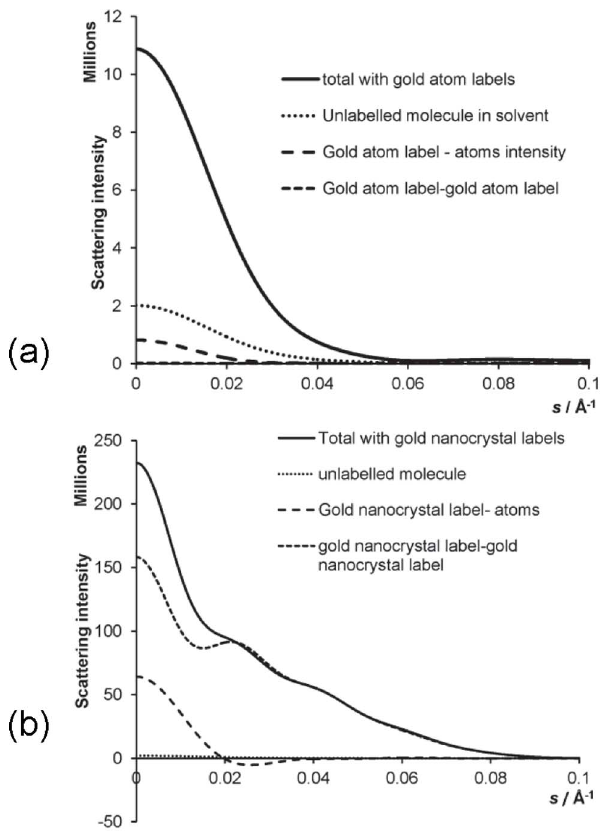
Figure 2. The intensity as a function of the momentum transfer vector magnitude, s , for a 10 base-pair DNA molecule in solvent at 12 keV beam energy showing the contributions from the molecule, label-atoms and label-label scattering (a) gold atom labels (b) gold nanocrystal labels. The total intensity includes simulated random errors (noise) but it cannot be seen on the scale of this plot.